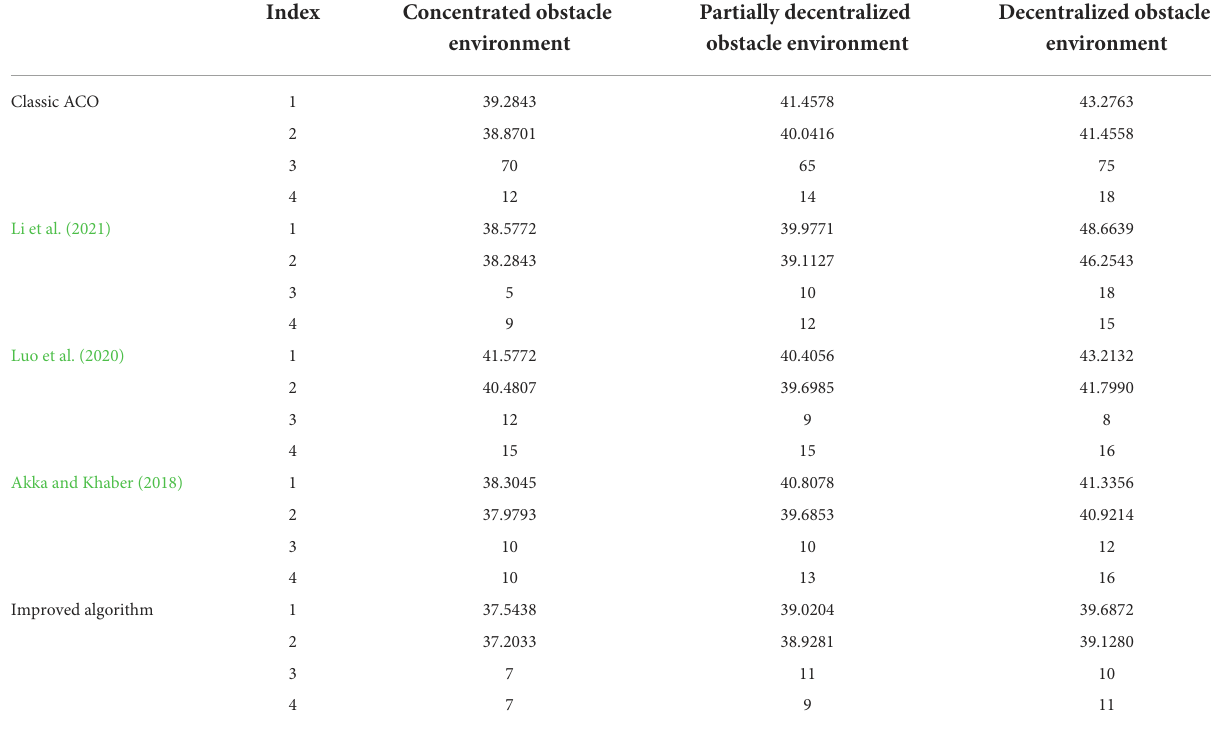
TABLE 3 Comparison of five